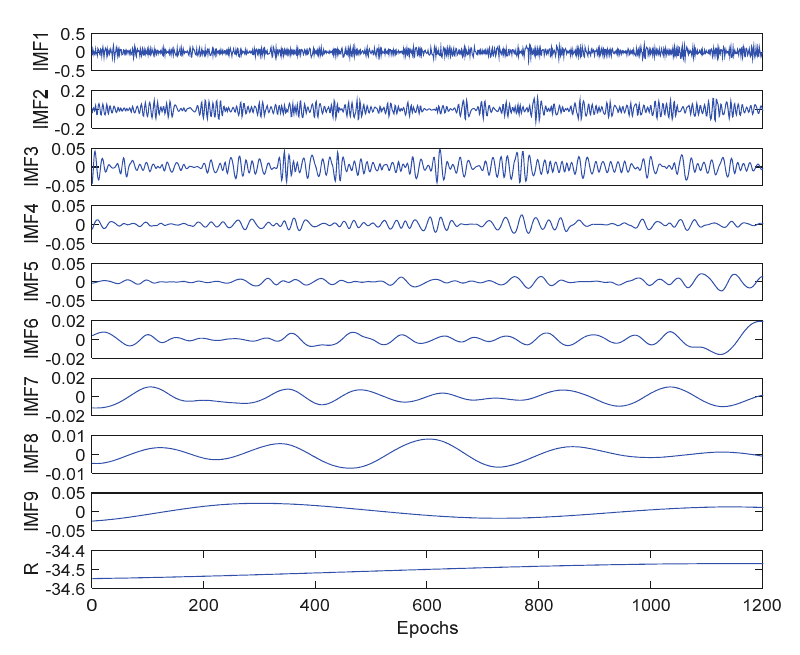
Figure 4. The decomposition results of the vertical carrier displacements via